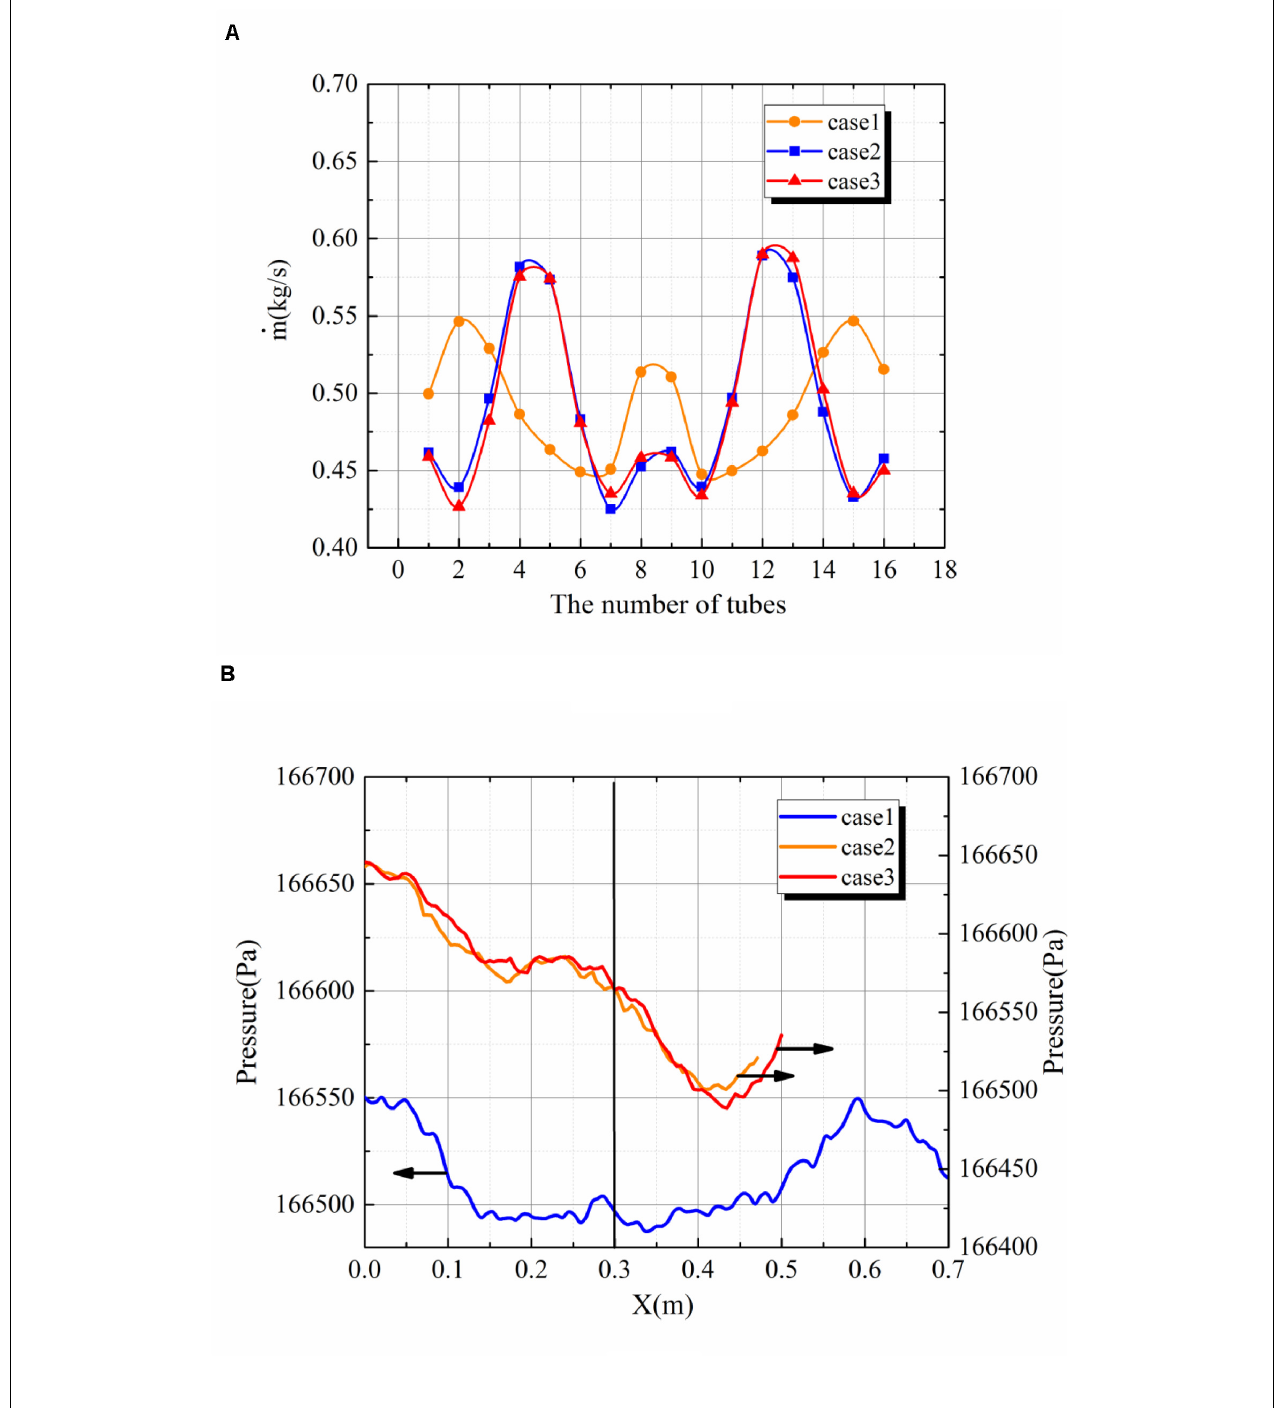
FIGURE 3 | (A) The flow distribution in tubes for case1, case2, and case3. (B) The pressure distribution in the dividing headers for case1, case2, and case3.